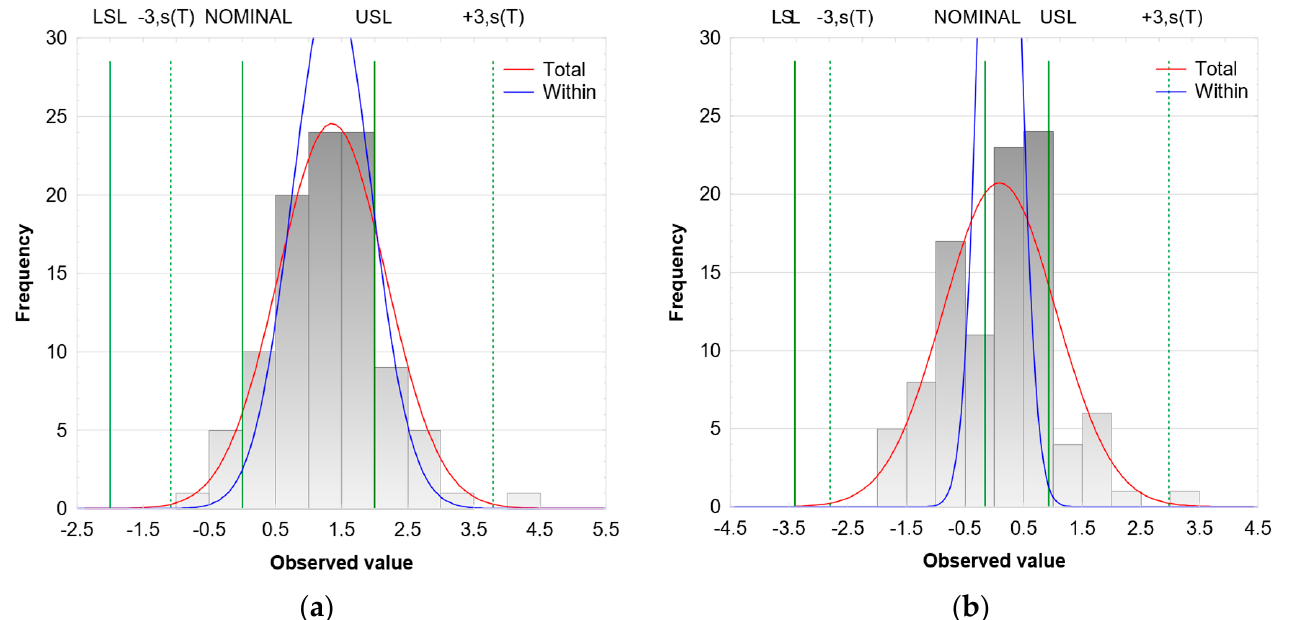
Figure 3. Distribution of the results obtained in a milling process conducted with ( a ) TiAlN-coated tool and ( b ) TiB 2 -coated tool and intermediate values of technological parameters.